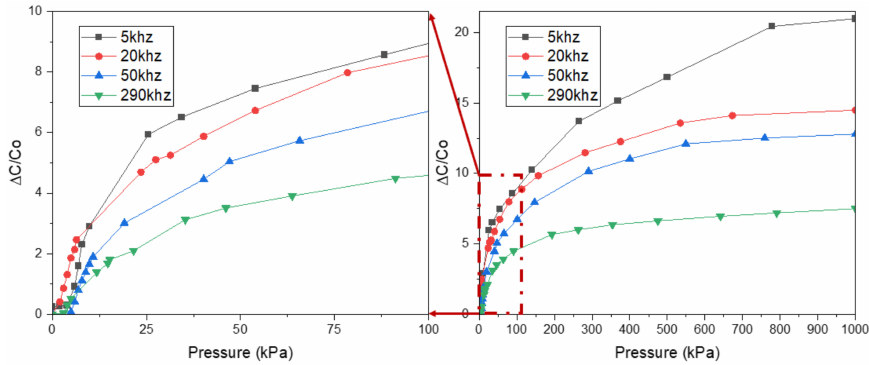
Figure 14. Pressure-response curves of capacitive pressure sensors (low density) at four frequencies.